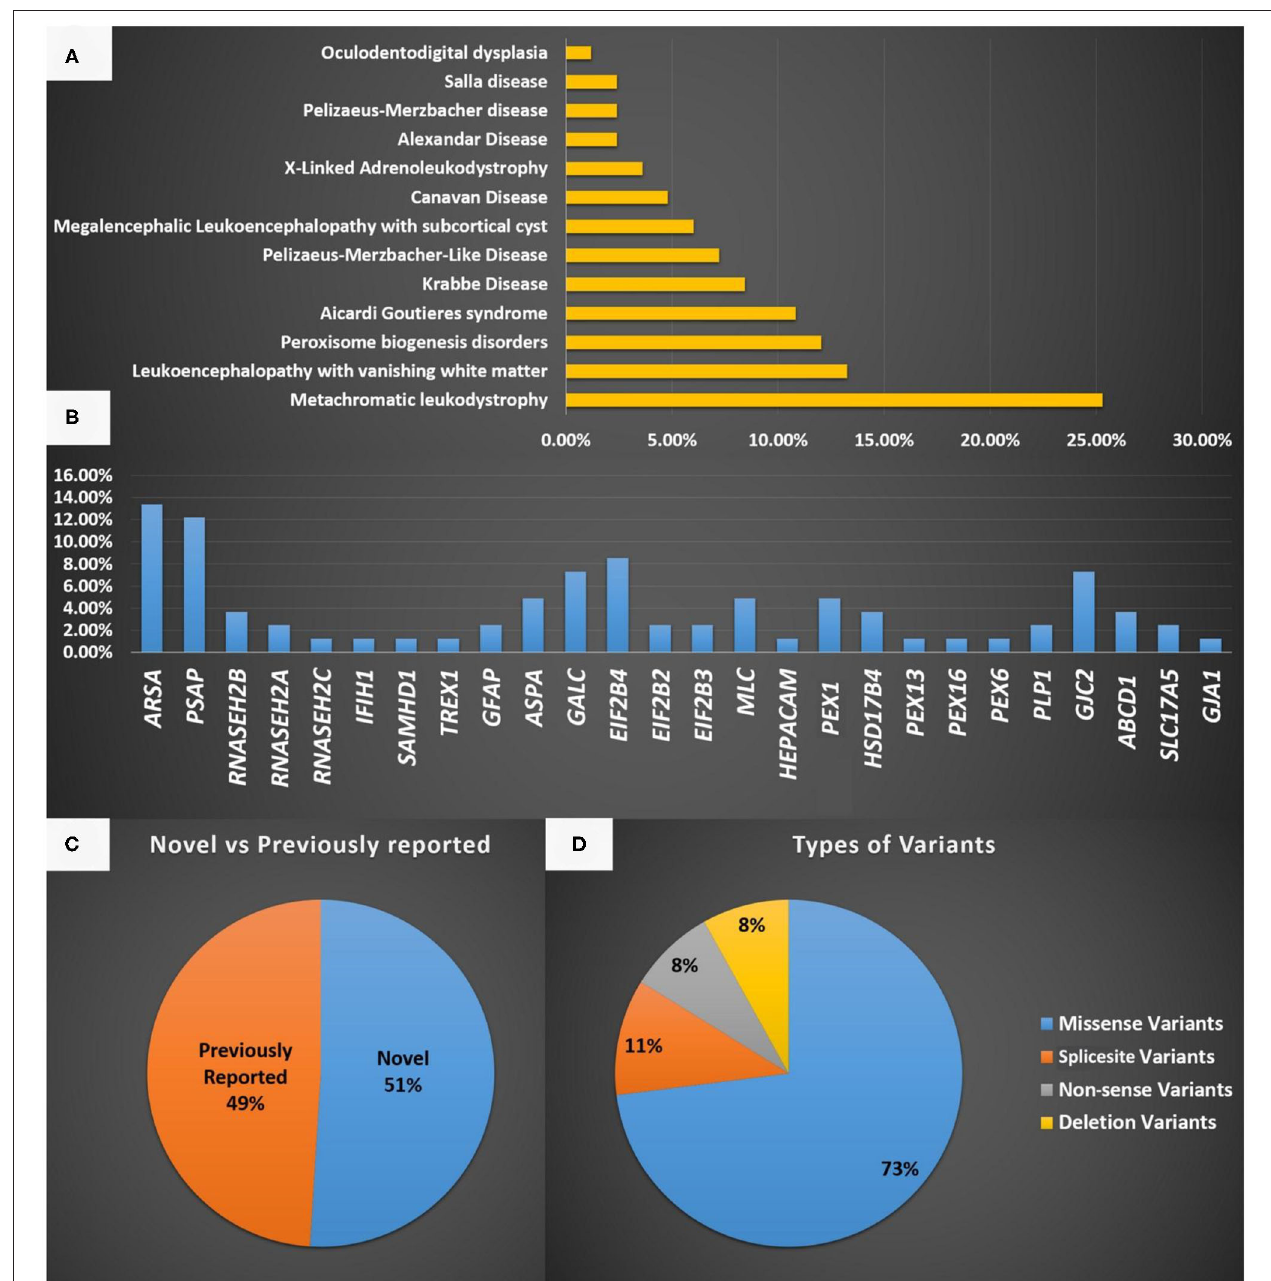
FIGURE 1 | (A) A representation of the different LD disorders included in our cohort and their percentages. (B) The genes reported in the LD disorder cohort in the present study. (C) Representation of novel and previously reported variants identified in the present study and the type of mutations identified. (D) Represent the type of variants identified in the present